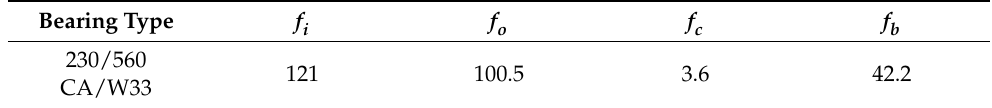
Figure 12. The engineering data with its envelope spectrum result: ( a ) Time domain waveform of the engineering data; ( b ) Envelope sepctrum of the signal as shown in ( a ).